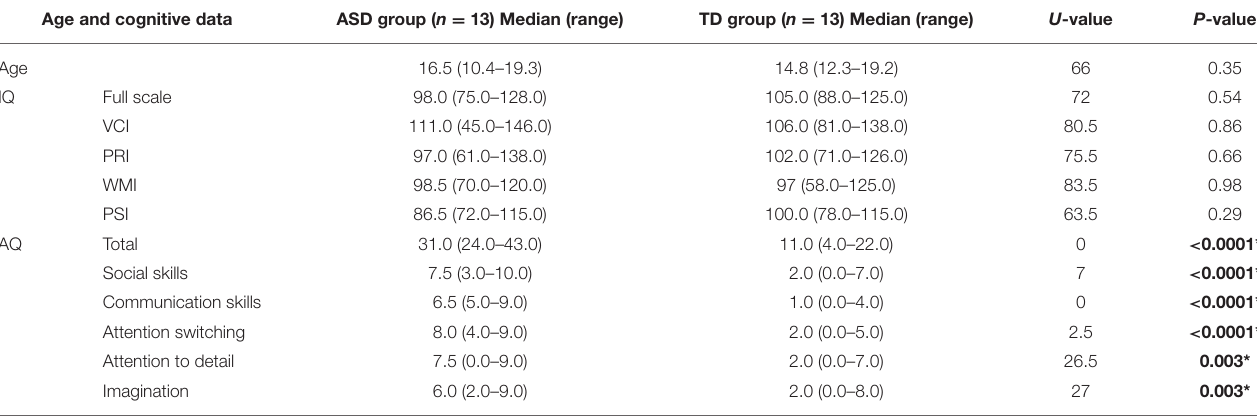
TABLE 1 | Median ages and cognitive data for the ASD and TD groups. Age and cognitive